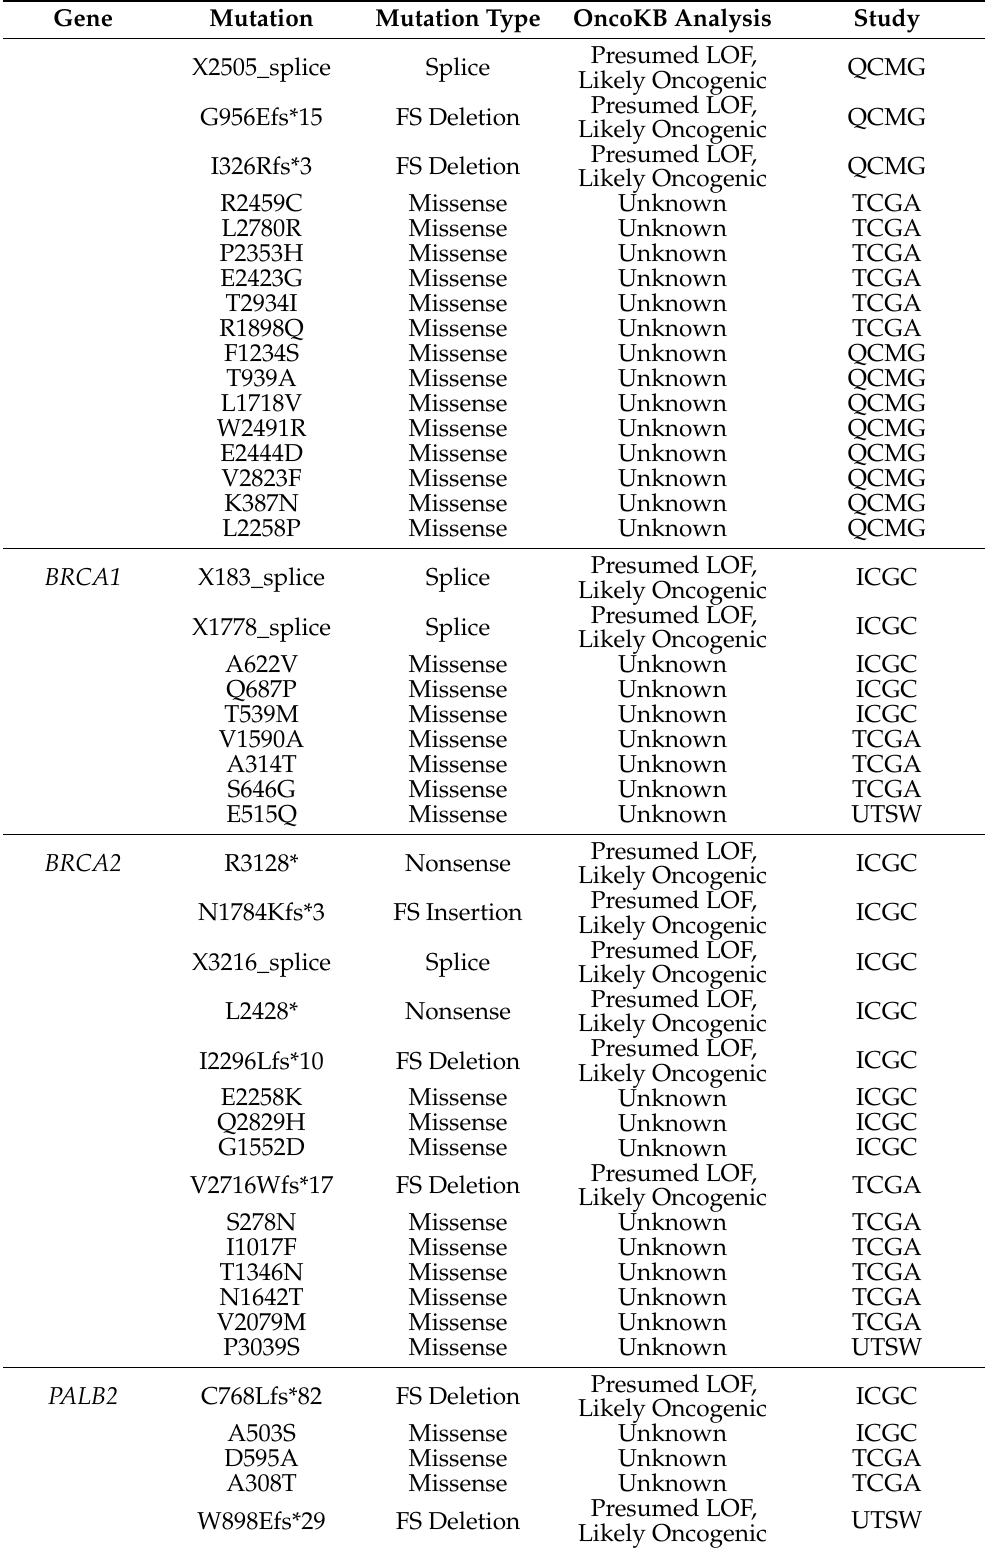
Table 2. Cont. Gene Mutation Mutation Type OncoKB